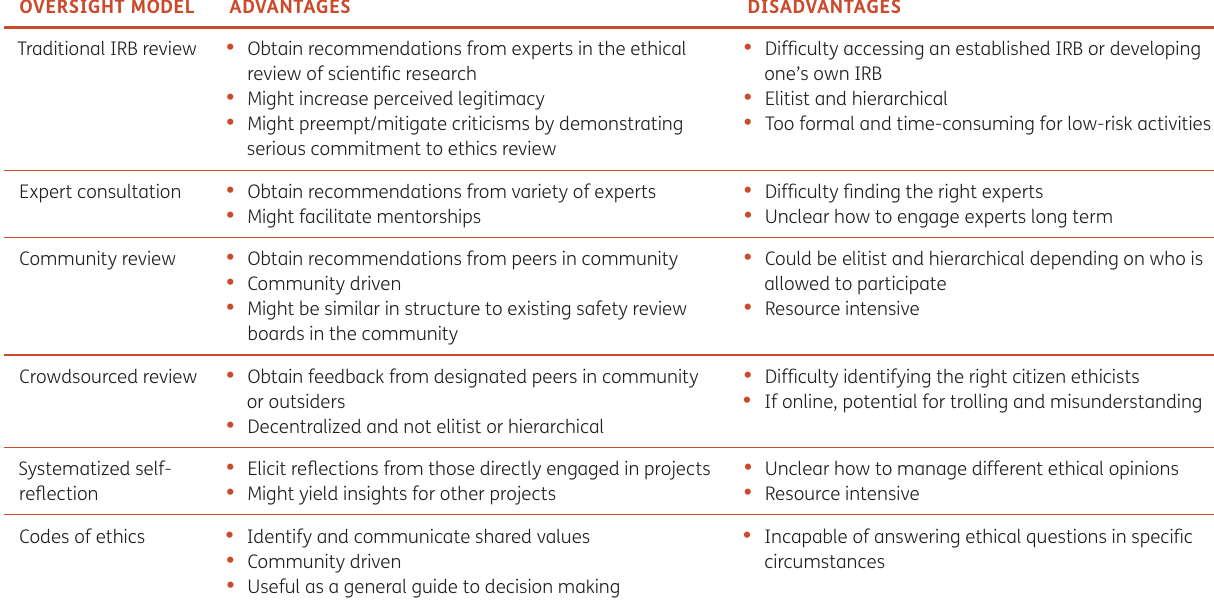
Table 2 Interviewees’ opinions of select ethical oversight